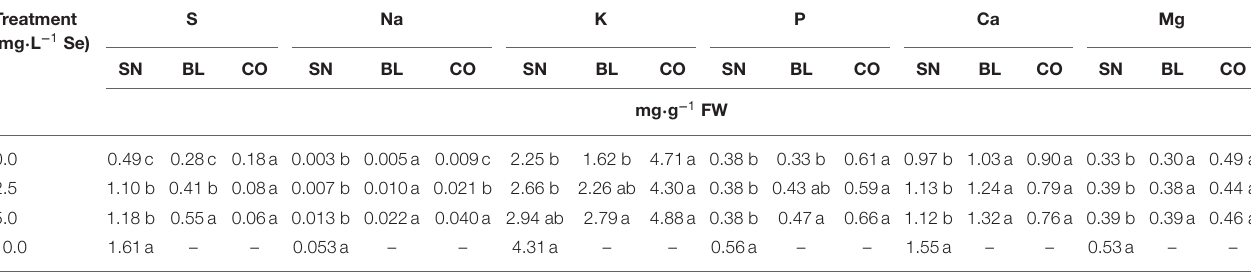
Values expressed as mean of three replications (n = 3) of each plant species. The Tukey’s significance at P ≤ 0.05 among Se treatments is indicated by different letters within the plant species for each given nutrient.